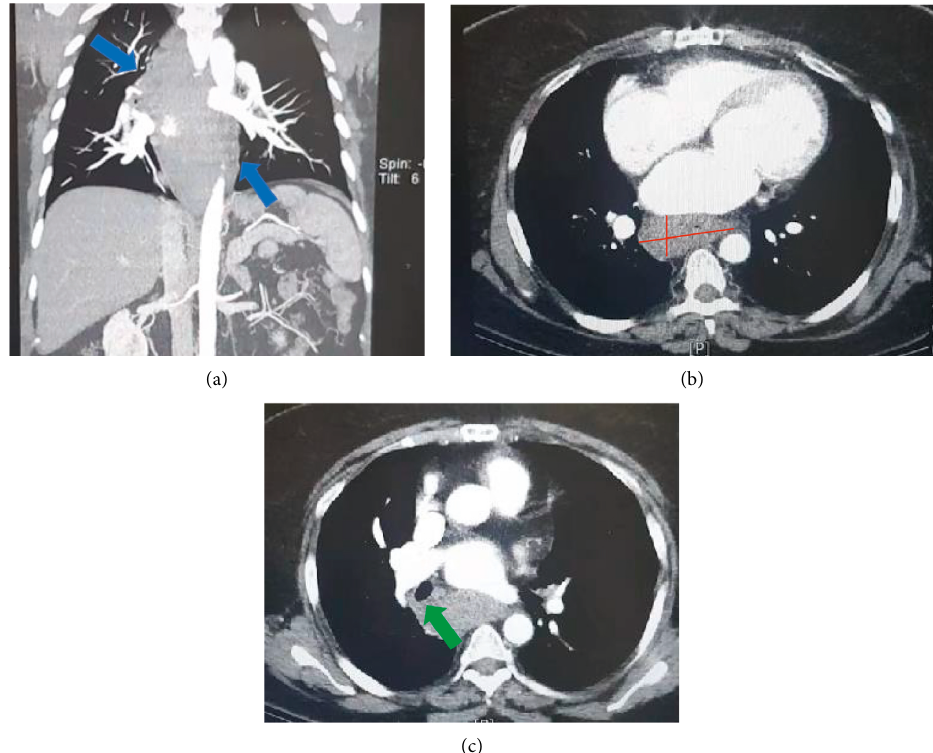
Figure 2: Contrast-enhanced axial and coronal computed tomography of the chest showing an abnormal esophageal contour beginning about 16cm from incisura extending about 20cm, terminating on LES ((a), blue arrows). The CTimages clearly show esophageal dilatation with a maximum lesion size of 5 × 2.2cm ((b), red lines), irregularity, and tracheal deviation caused by hematoma ((c), green arrow) (date performed: December 21, 2021)